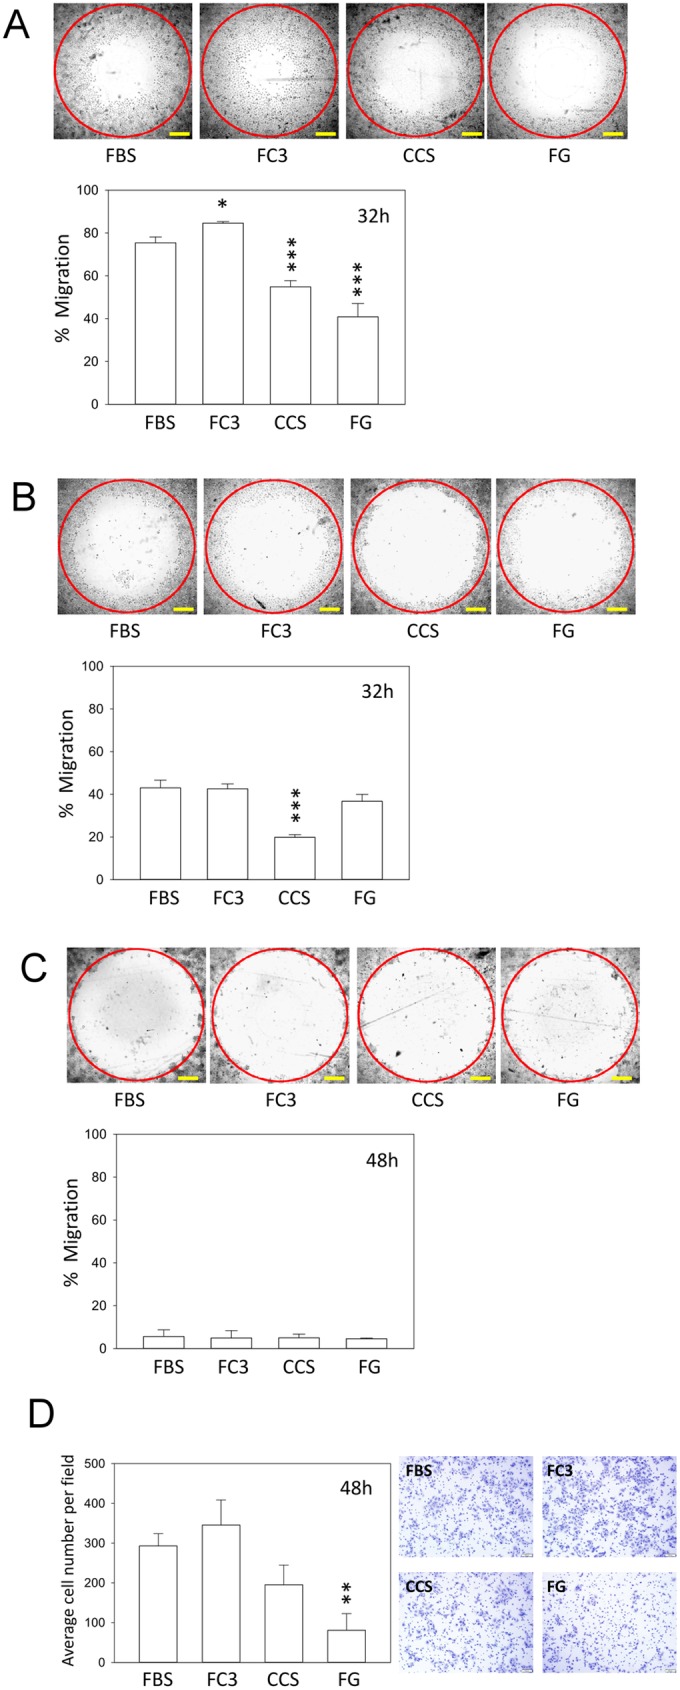
Migration and invasion of cells cultured in alternative sera.Migration of cells cultured in FBS and alternative sera at indicated times. The red circle represents the cell front at t = 0 h when the stopper was removed. Yellow bar represents 200 μm. (A) TW01, (B) HONE-1, and (C) FaDu cells. (D) The invasiveness of TW01 cells was determined by the number of cells that invaded and transmigrated to the lower surface of the transwell membrane at 48 h. Data indicate the average value of three wells (migration) or three culture inserts (invasion) (mean ± SD). *:p<0.05; **:p<0.01; and ***:p<0.001 compared with cells cultured in FBS.